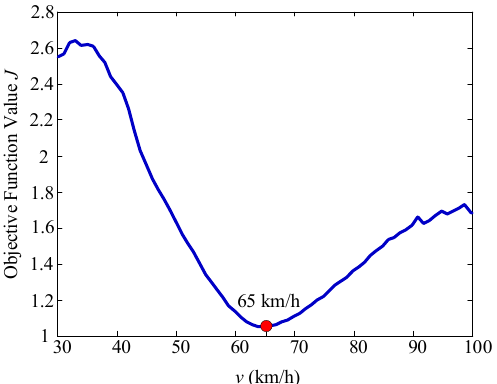
Figure 7. The objective function value under fitting periodic road excitation. In Figure 7, when the vehicle speed varies from 30 km/h to 100 km/h, with the increase of vehicle speed, the objective function value J decreases first and then increases. At the vehicle speed of 65 km/h, the objective function J is the smallest, that is to say, the optimal vehicle speed is 65 km/h, when the vehicle passes through fitting periodic road excitation at this speed, the comprehensive vibration reduction performance of ISD suspension is the best. The result shows that the vehicle speed of 65 km/h is selected to analyze the performance improvement of ISD suspension compared with passive suspension. To demonstrate the dynamic responses of the vehicle system, the dynamic characteristics under fitting periodic road excitation are shown in Figure 8.